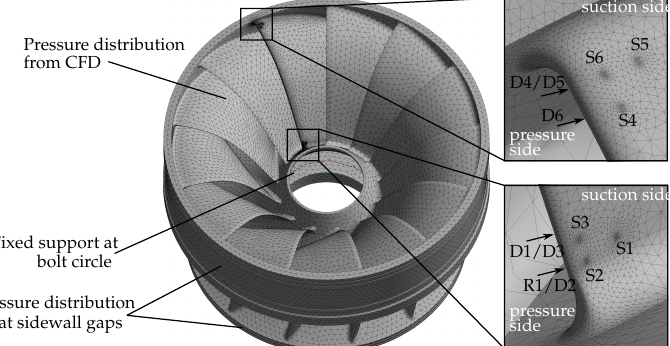
Figure 19. Model setup and discretization of the transient structural